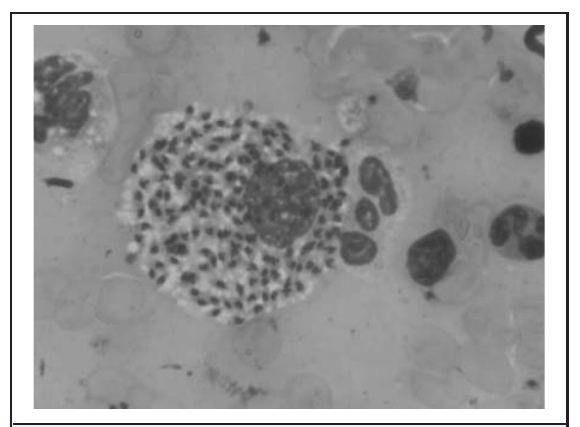
Figure 4. FNAC smear, Giemsa stain, 100x; his- tiocyte containing amastigote of Leishmania. Back- (cid:10)(cid:7)(cid:20)(cid:14)(cid:3)(cid:18)(cid:11) (cid:21)(cid:17)(cid:20)(cid:16)(cid:21)(cid:11) (cid:23)(cid:17)(cid:7)(cid:20)(cid:3)(cid:9)(cid:23)(cid:11) (cid:9)(cid:3)(cid:25)(cid:8)(cid:26)(cid:26)(cid:8)(cid:6)(cid:20)(cid:7)(cid:27)(cid:11) (cid:23)(cid:15)(cid:5)(cid:5)(cid:21)(cid:11) (cid:9)(cid:3)(cid:23)(cid:5)(cid:14)(cid:18)(cid:9)(cid:3)(cid:10)(cid:11) plasma cells and a few